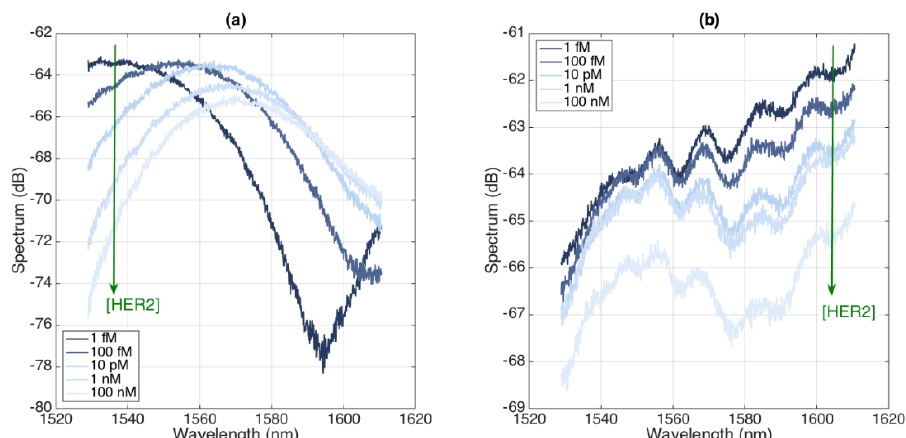
Figure 10. Spectra of BR sensors functionalized for CD44 detection, for different concentrations ranging from 1 fM to 100 nM. ( a ) First sensor; ( b ) second sensor.